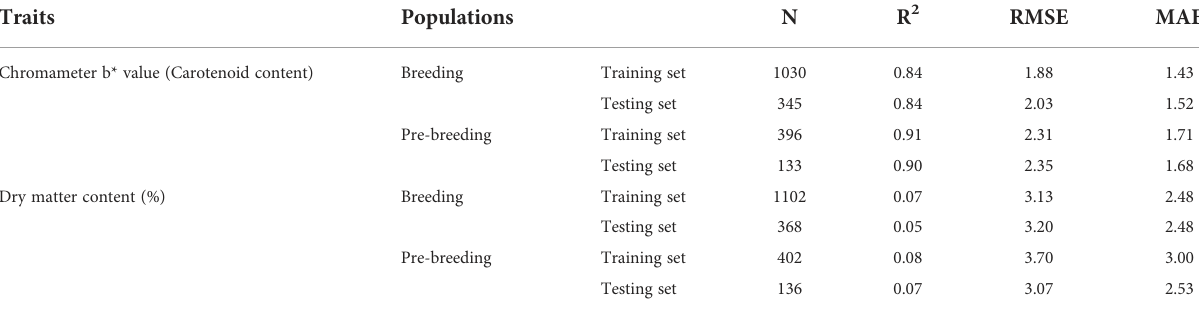
Dry matter content (%)